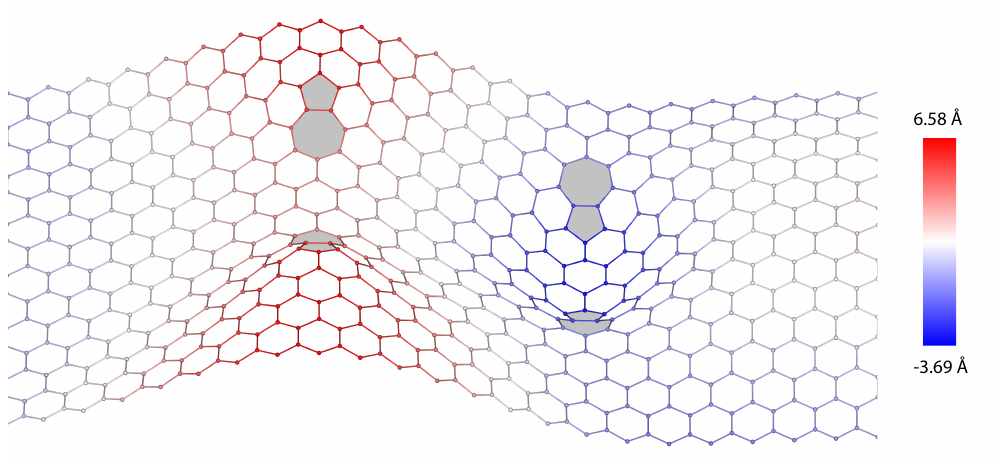
Figure 10. More stable mode of deformed configurations of periodic quadrupolar arrangement of dislocations in